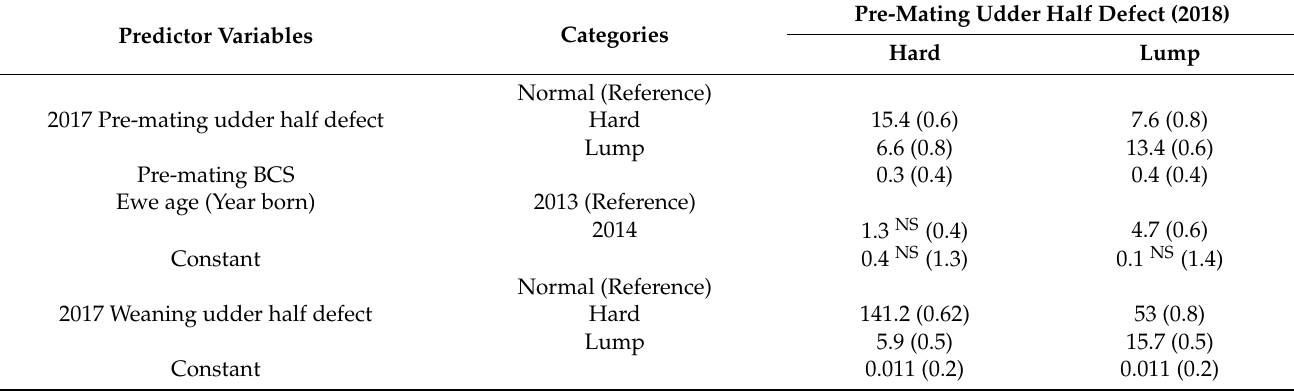
Table 4. Predicted relative risk ratio (RRR ± standard error) of 2018 pre-mating udder half defect occurrence based on 2017 pre-mating and weaning udder half defect status from 1408 udder halves (from 704 non-dairy Romney ewes) (Study